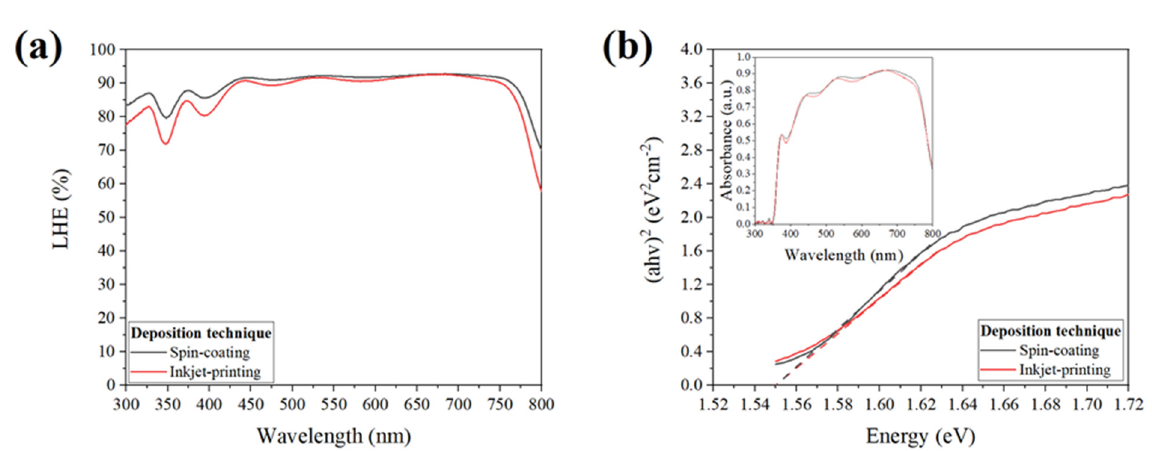
Figure 5. ( a ) LHE of the perovskite films fabricated on the TiO 2 -based working electrode and ( b ) Tauc plots for the perovskite films fabricated by the different deposition techniques.